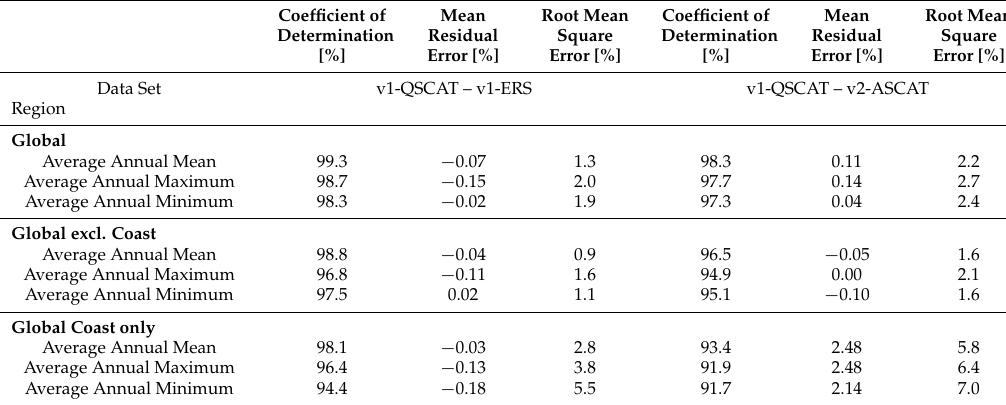
Table 5. Summary statistics from pixel-wise comparisons of average annual mean, maximum and minimum fractional water (FW) generated from v1-QSCAT (2000–2008) against corresponding FW record from v1-ERS (1992–2000) and v2-ASCAT (2009–2012) over the global domain, by excluding coastal regions and for coastal regions alone. Relationships are significant at a minimum 0.01 probability